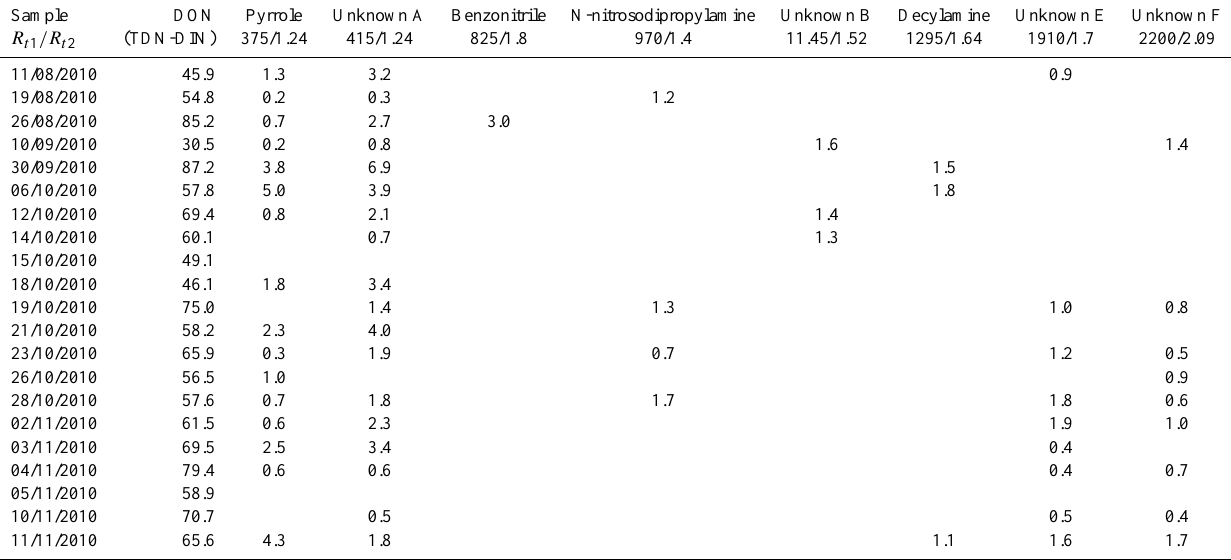
Table 5. Summary of compounds and their concentrations (µmolNL − 1 ) detected by the GC × GC-NCD, and DON concentrations (µmolNL − 1 ) detected by Antek in stream-water samples. Samples collected on dates shaded in grey did not contain compounds at measur- able concentrations by the GC × GC-NCD. Blank spaces indicate a measured value of below the detection limit. R t 1 and R t 2 are retention times in seconds for the first and second GC columns. Sample DON